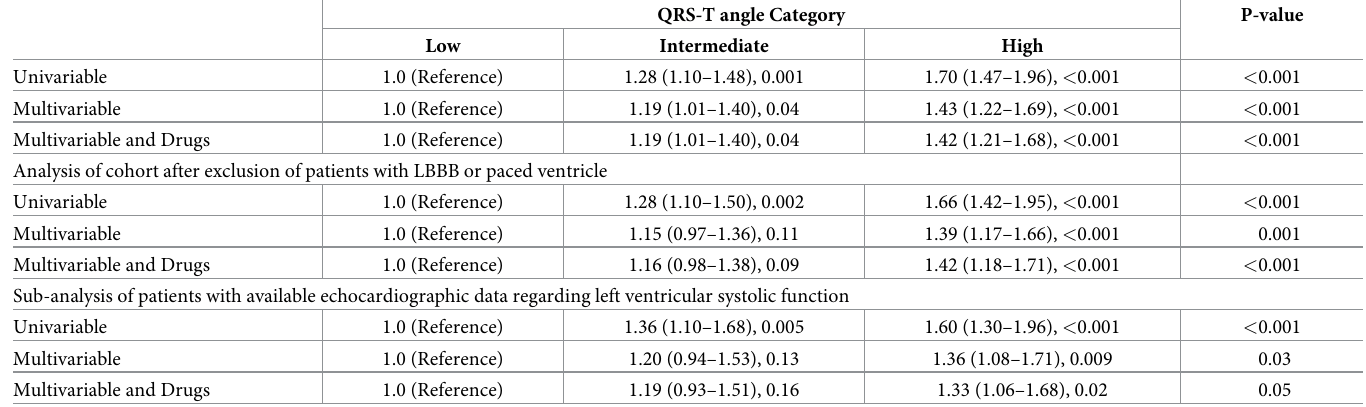
Table 3. Hazard ratio for clinical outcome according to QRS-T angle levels by Cox regression